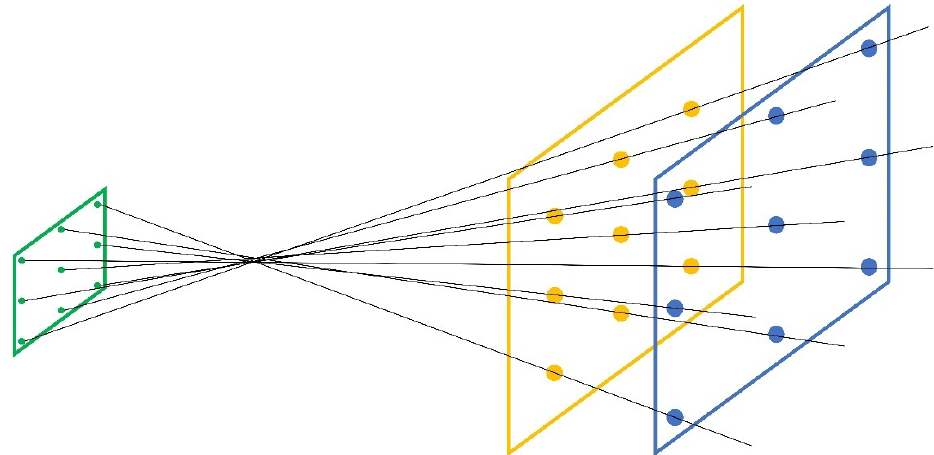
Figure 3. Image plane (green) and two reference planes E 1 and E 2 in the WSC.